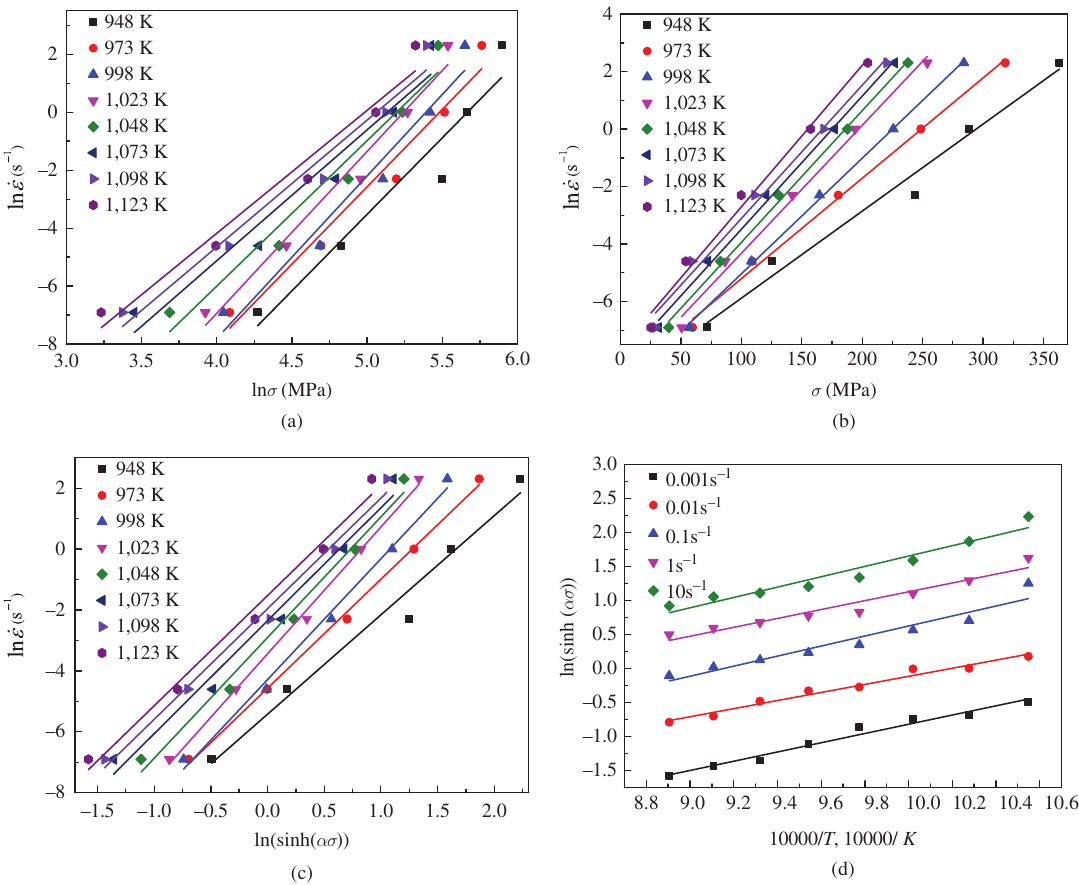
Figure 12 Relationships between (a) ln _ " (cid:5) ln σ , (b) ln _ " (cid:5) σ , (c) ln _ " (cid:5) ln ð sinh ð ασ ÞÞ , (d) ln ð sinh ð ασ ÞÞ (cid:5) 10 ; 000 = T at strain of 0.5